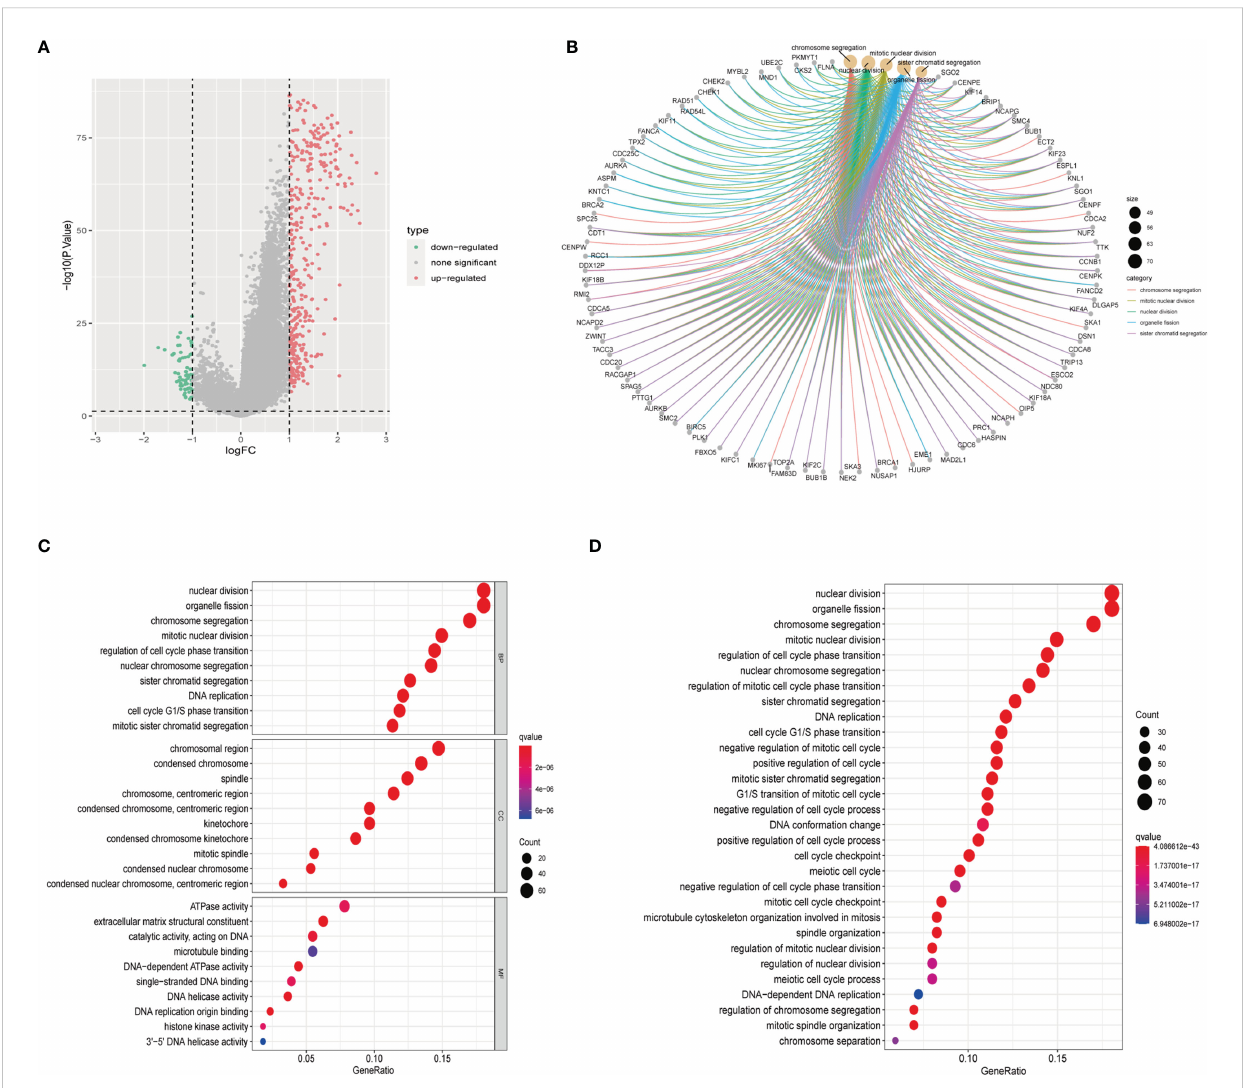
FIGURE 4 Identi fi cation and enrichment analysis of DEGs from two CRGs subtypes. (A) Volcano plot of difference analysis between the two CRGs subtypes to identify DEGs. (B) The network map displays the correspondence between the KEGG top fi ve pathways and related genes. (C) GO enrichment analysis of DEGs. BP, Biological Process; CC, Cellular Component; MF, Molecular Function (D) KEGG enrichment analysis of DEGs. CRGs, centrosome related genes; DEGs, differentially expressed